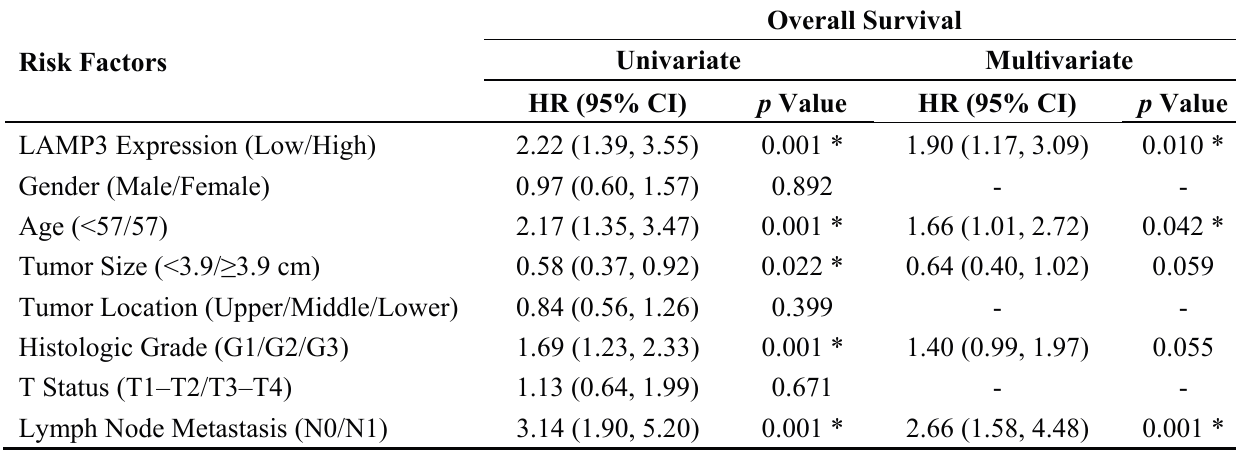
Figure 3. Kaplan-Meier survival curves for ESCC patients with high and low expression levels of LAMP3. ( a ) 5-year OS curves for 157 ESCC patients; ( b ) 5-year DFS curves for 157 ESCC patients. ESCC patients with high expression level of LAMP3 had poor OS and DFS ( p = 0.001, log-rank test). Table 2. Univariate and multivariate survival analysis for overall survival according to the Cox regression